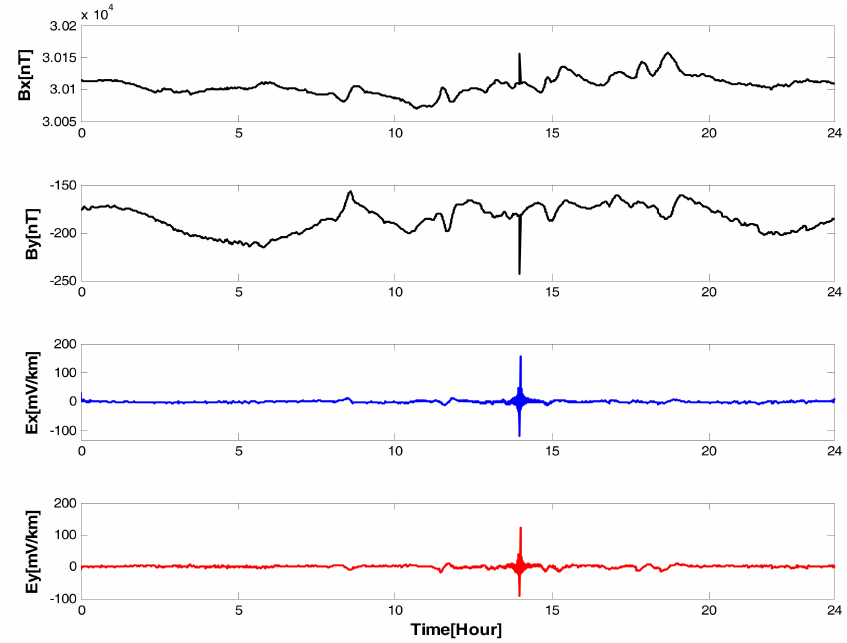
Figure 2. Calculated geoelectric fields on 19 October 2003 at the Icheon